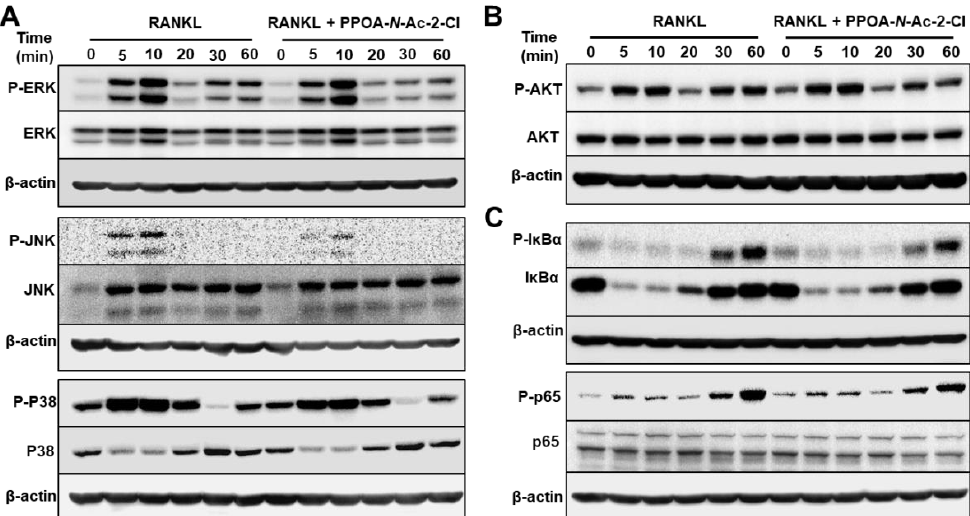
Figure 6. PPOA- N -Ac-2- Cl attenuates osteoclastogenesis via inhibition of MAPK and IκBa/p65 (NF - κB) signaling pathways. ( A – C ) BMMs were stimulated with 100 ng/mL RANKL for 0, 5, 10, 20, 30, or 60 min after pretreatment with 6 μM PPOA - N -Ac-2-Cl or DMSO for 2 h, and the phosphorylation of MAPKs, Akt, IκBa, and p65 was analyzed by immunoblotting . The densitometry graphs for the blots are shown in Figure S3. β -actin was used as the loading